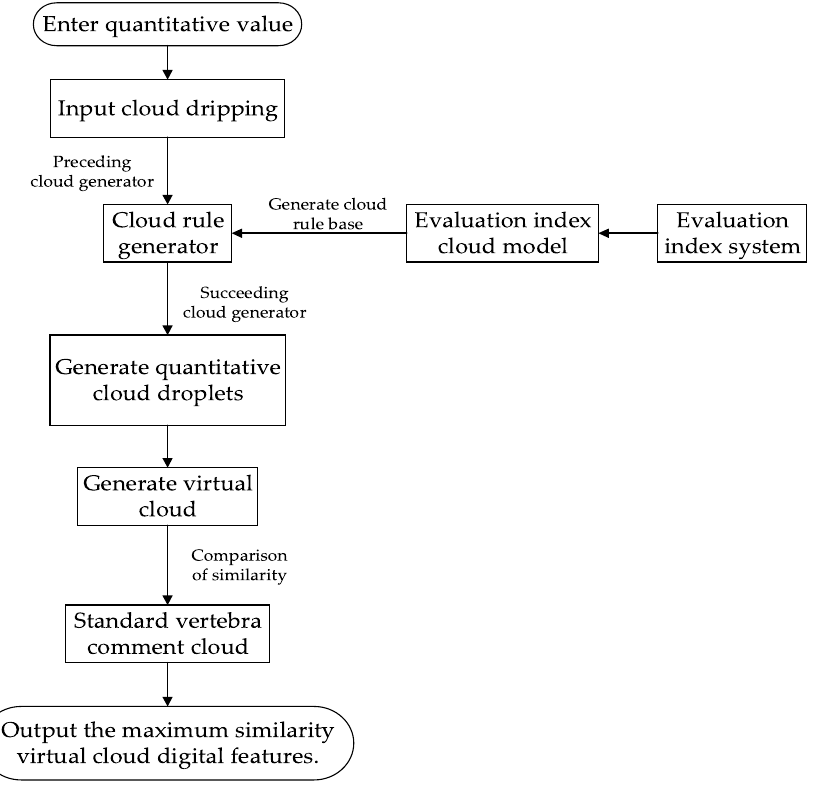
Figure 6. Cloud reasoning system